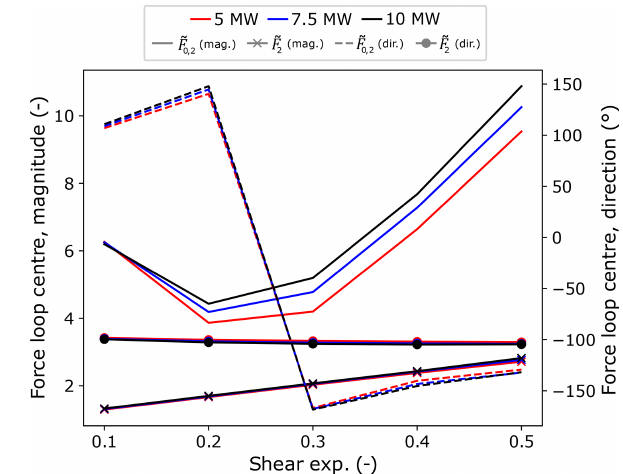
Figure C1. Non-dimensionalised, downwind-row, radial force- loop-centre magnitude and direction values for overhung ( ˜ F 0 , 2 ) and centred ( ˜ F 2 ) main-bearing configurations across the three modelled turbines as the shear exponent is varied.